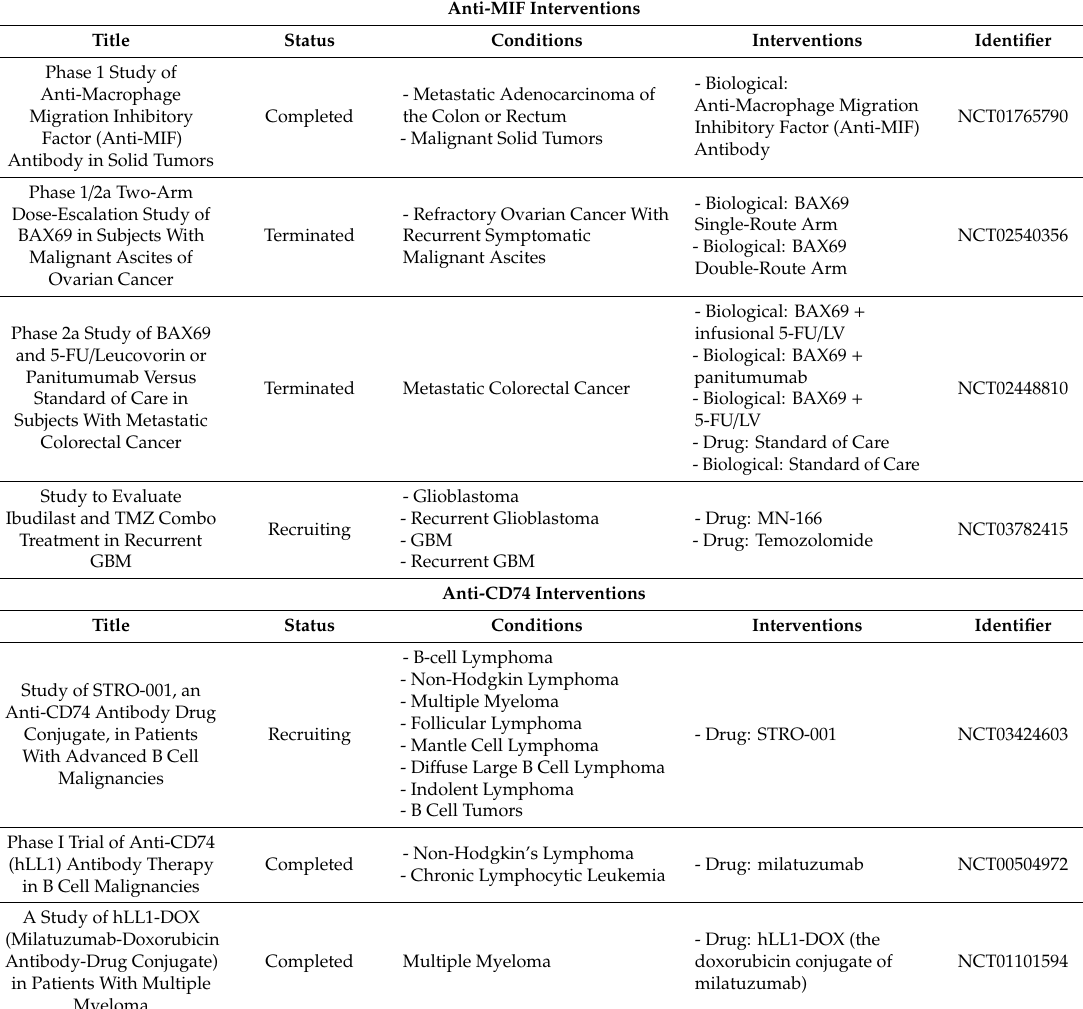
Table 2. MIF and d -dopachrome tautomerase (DDT) inhibitors in clinical